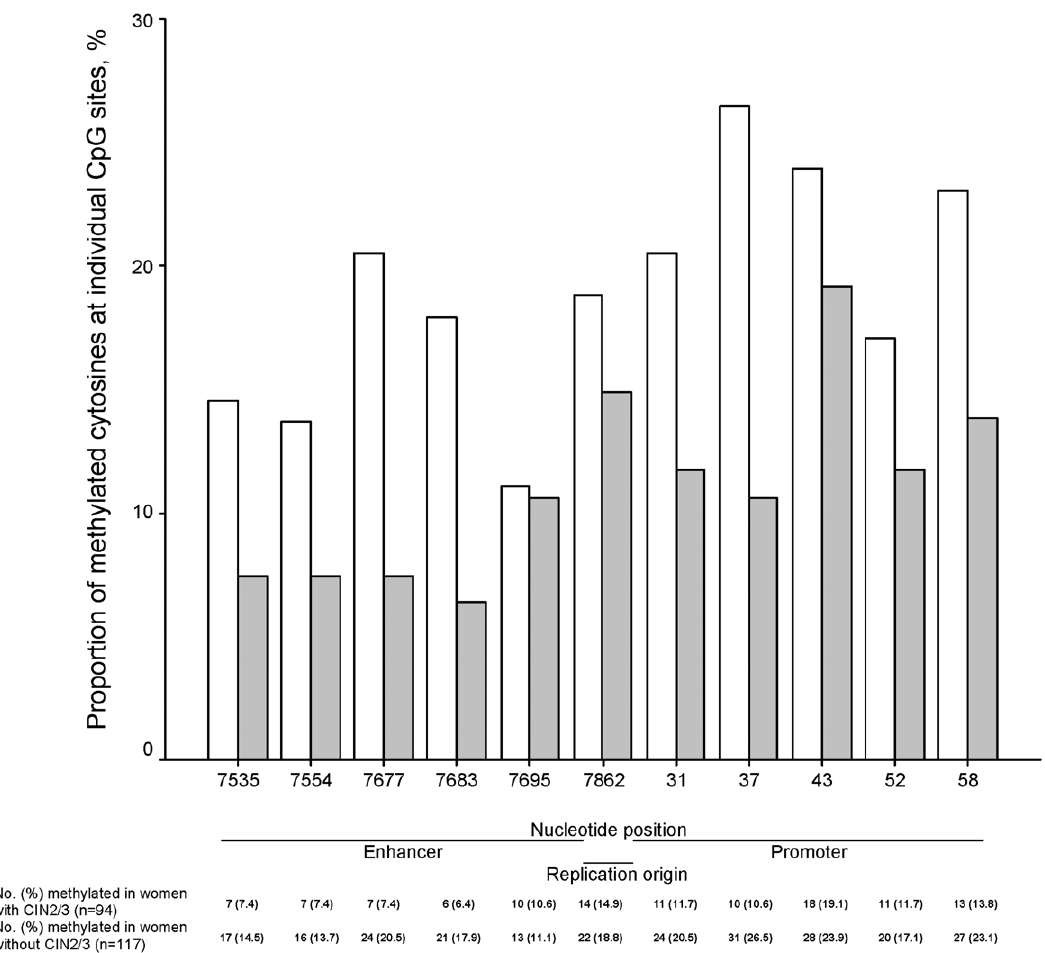
Figure 2. Proportions of the methylated cytosine at individual CpG dinucleotides between women with and without CIN2/3. Grey and white bars represent women with and without a diagnosis of CIN2/3, respectively. The numbers above the nucleotide position indicate a cytosine’s position of each CpG dinucleotides in the 3 9 end of the long control region of HPV16 genome.